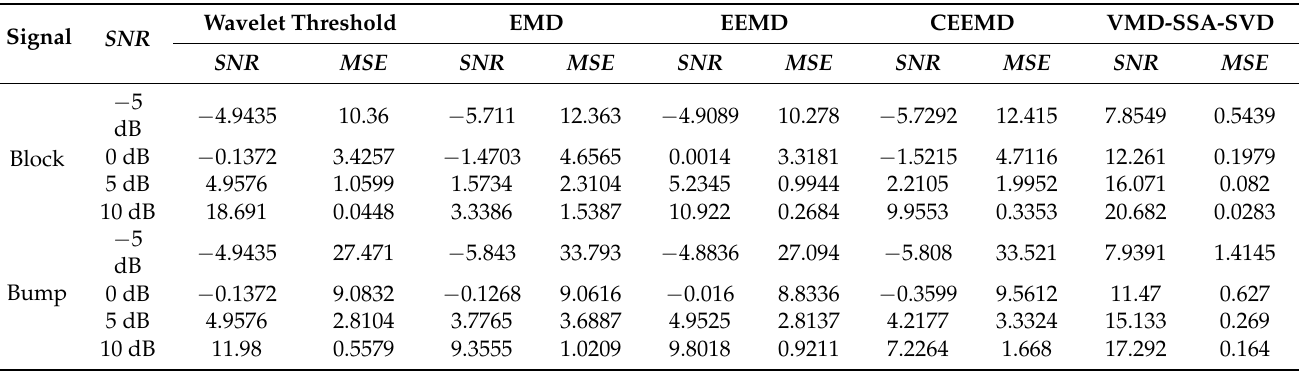
Table 1. The SNR and MSE after noise reduction by five methods when superimposed with noise with different SNRs .